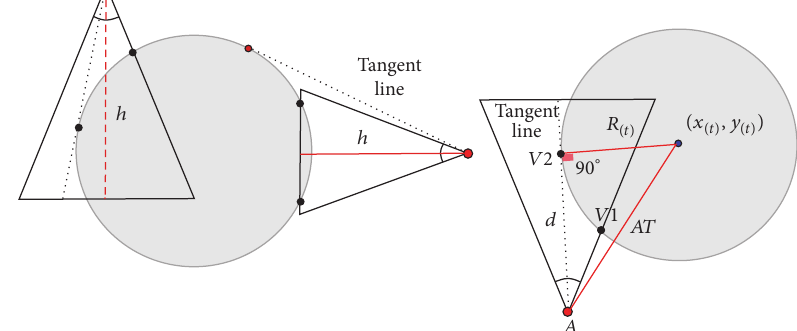
Figure 4: Computing tangent